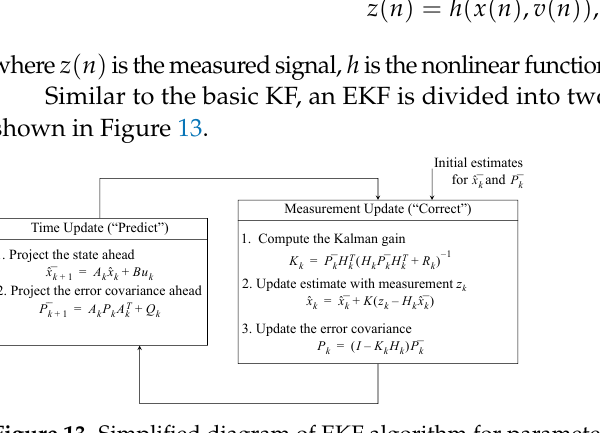
Figure 13. Simplified diagram of EKF algorithm for parameter